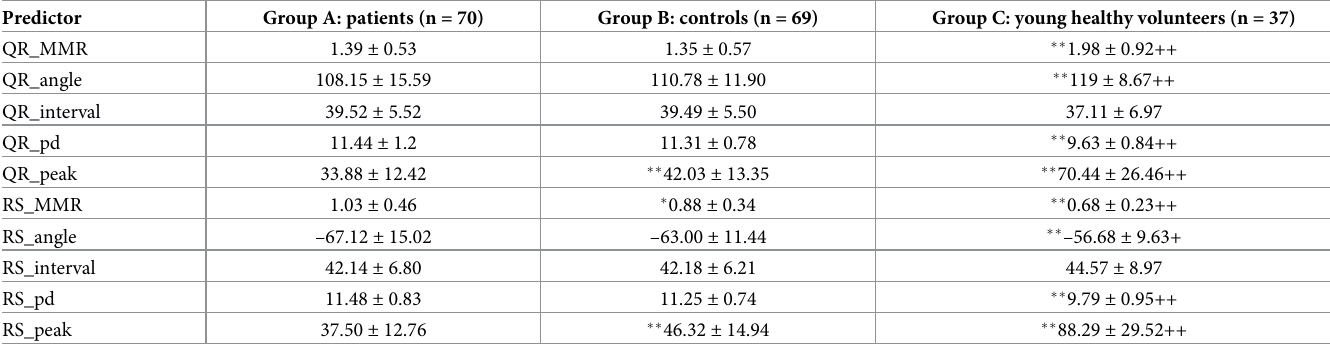
Table 2. Average value for each predictor for patient and control groups.